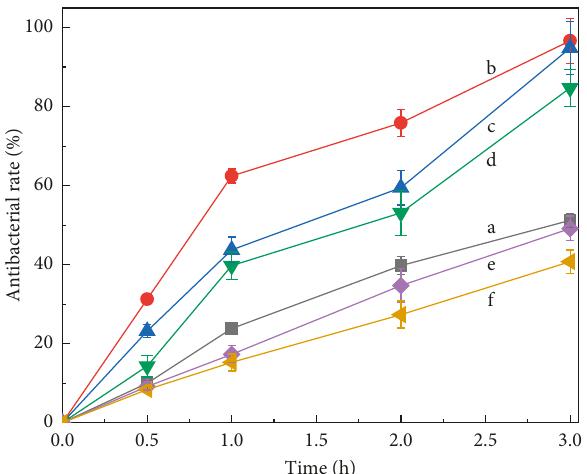
2 , (b) 0.1 at%, (c) 0.5 at%,